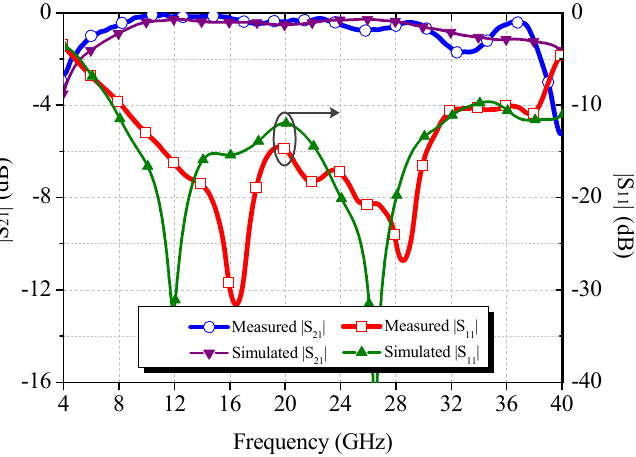
Figure 6. Measured and simulated S-parameters of the fabricated phase inverter.